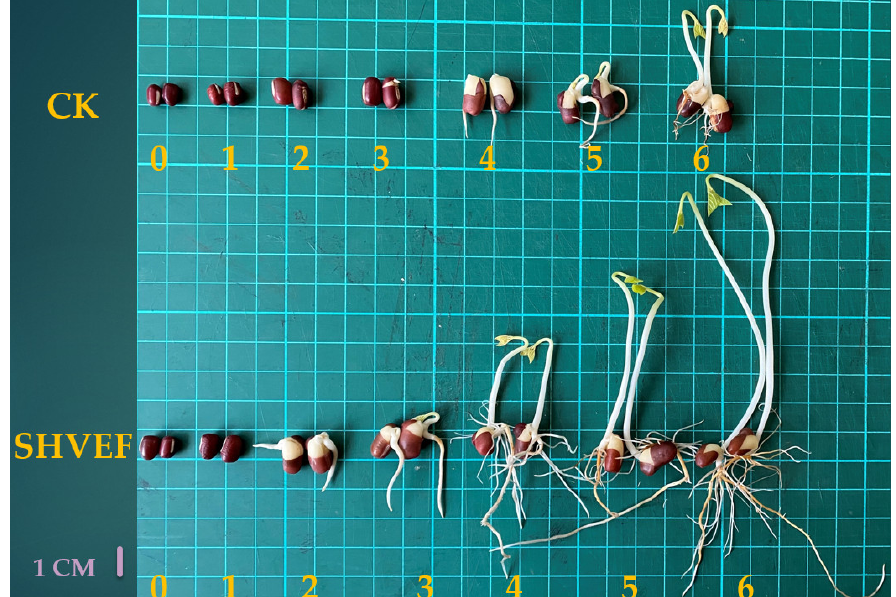
Figure 3. Development of untreated control (CK) and SHVEF treated adzuki bean sprouts sampled from day 0 to day 6. from day 0 to day